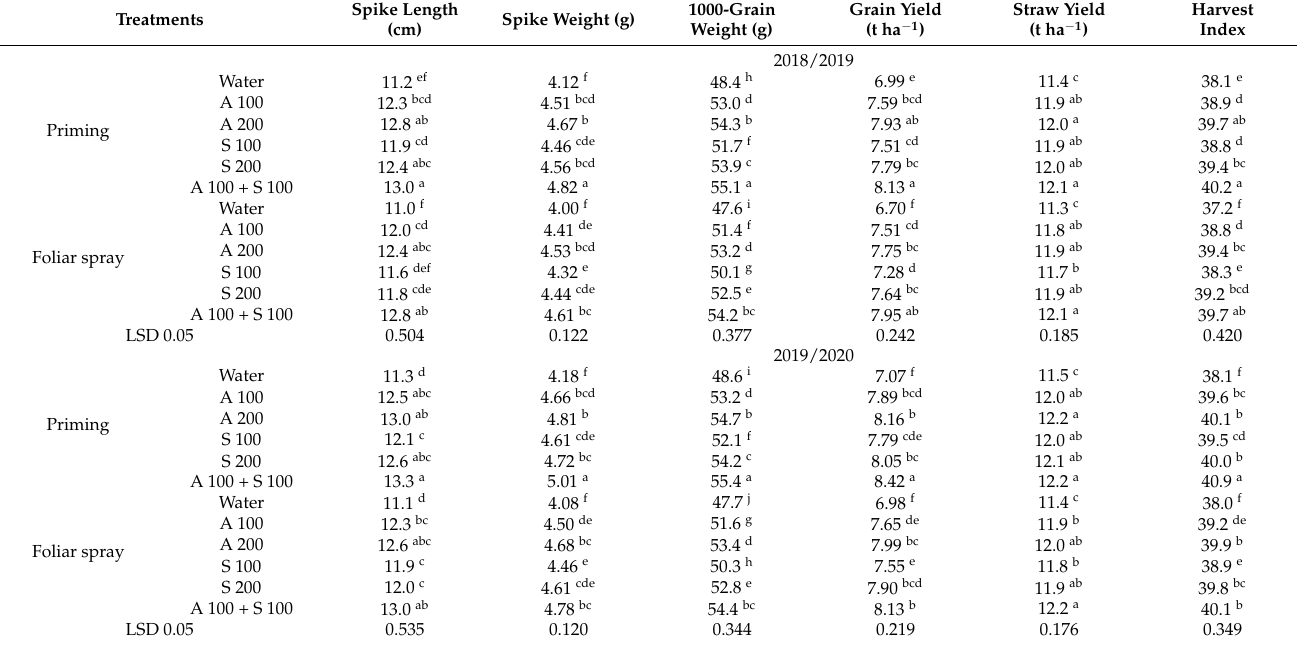
Table 4. Yield and yield attributes of wheat affected by foliar and priming application with various rates of antioxidants during 2018/2019 and 2019/2020 seasons.